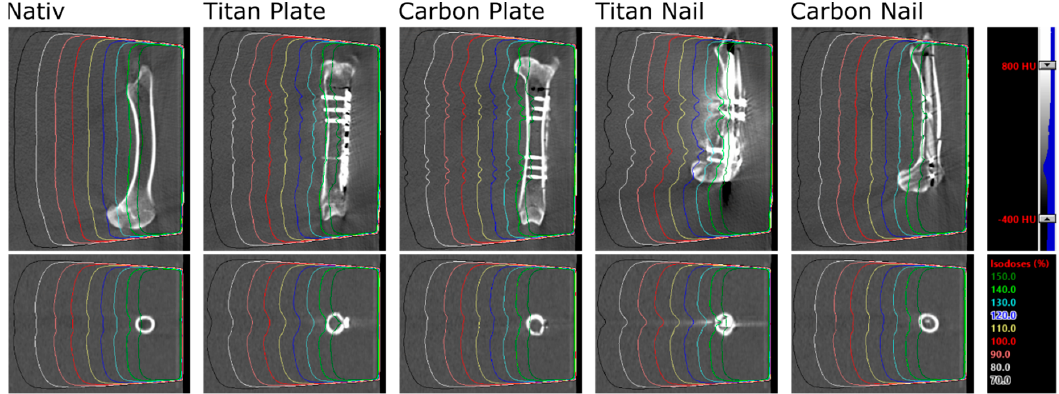
Figure 4. CT images and calculated dose distributions for all bones and implants at 5 cm immersion depth. Densities from − 400 to 800 HU are shown in grey scale; isodose levels of a 6 MV, 20 × 20 cm 2 field are shown in color.